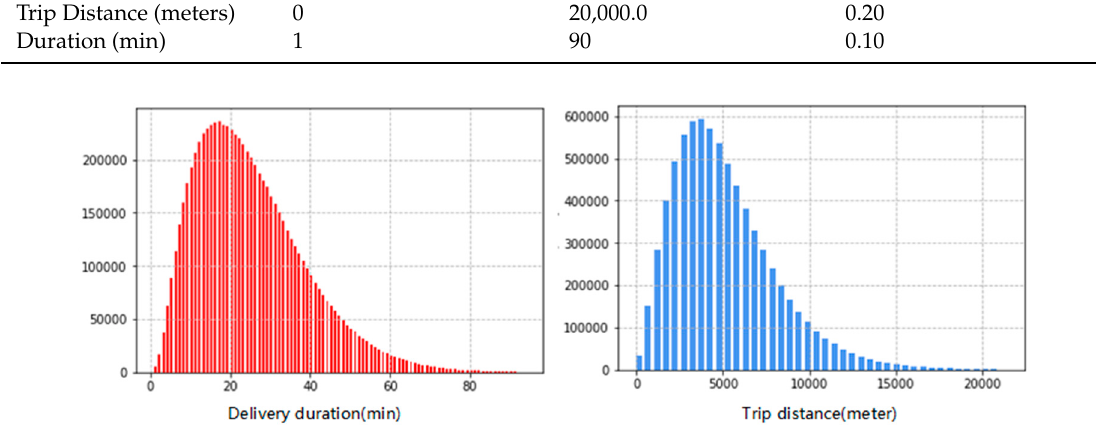
Figure 3. Delivery duration and trip distance distribution after filtering.